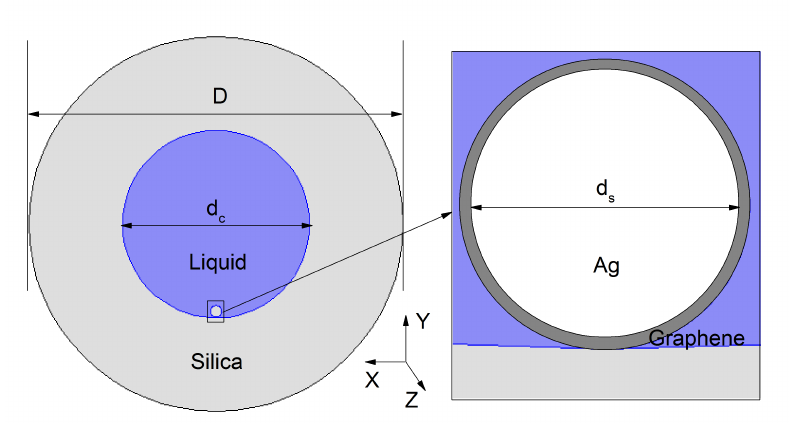
Figure 1. Cross section of the designed temperature